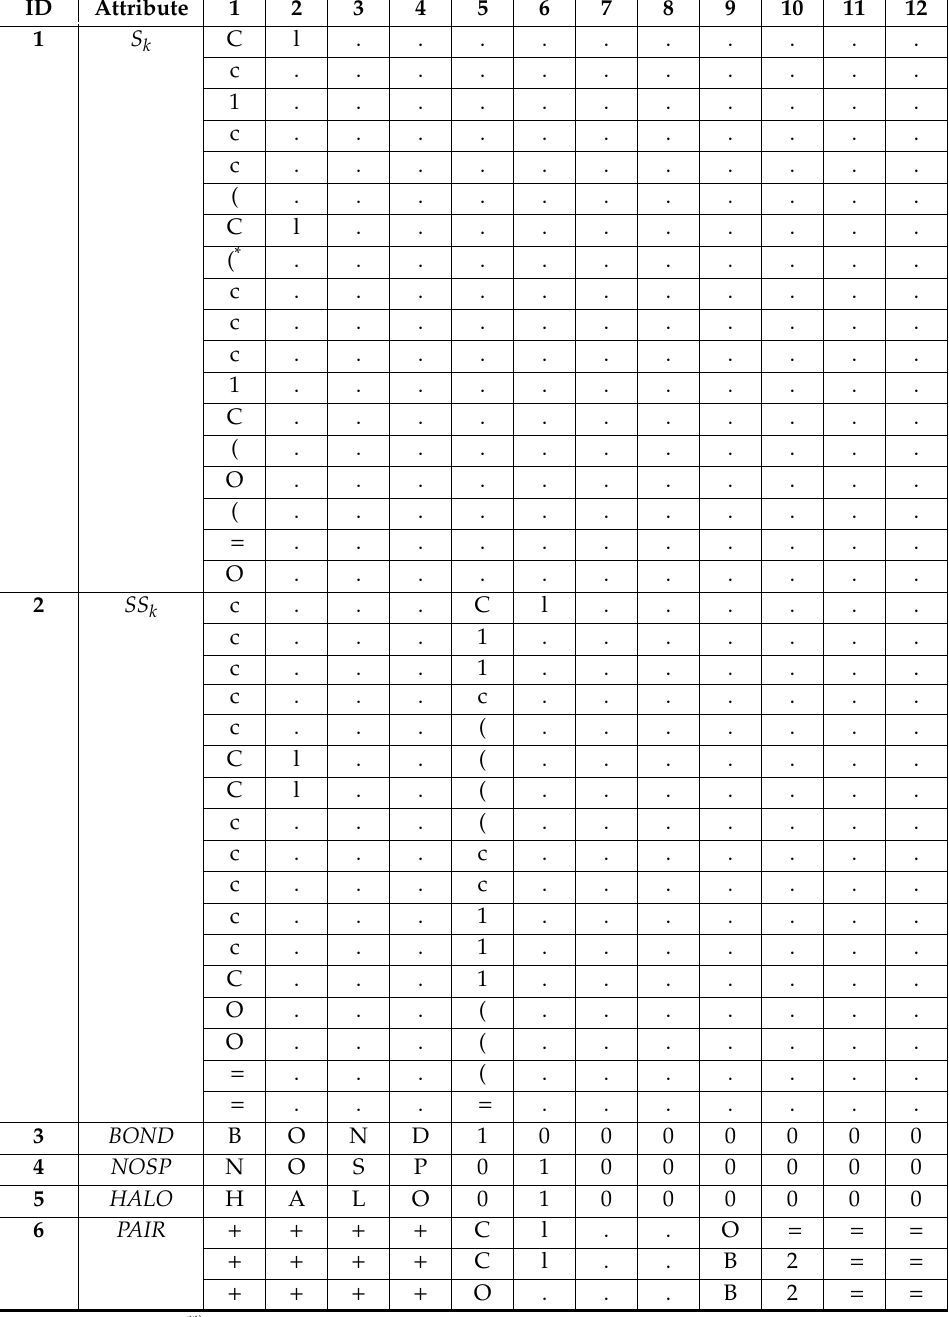
Table 5. Generalized representation of above SMILES attributes for Clc1cc(Cl)ccc1C(O) = O. ID